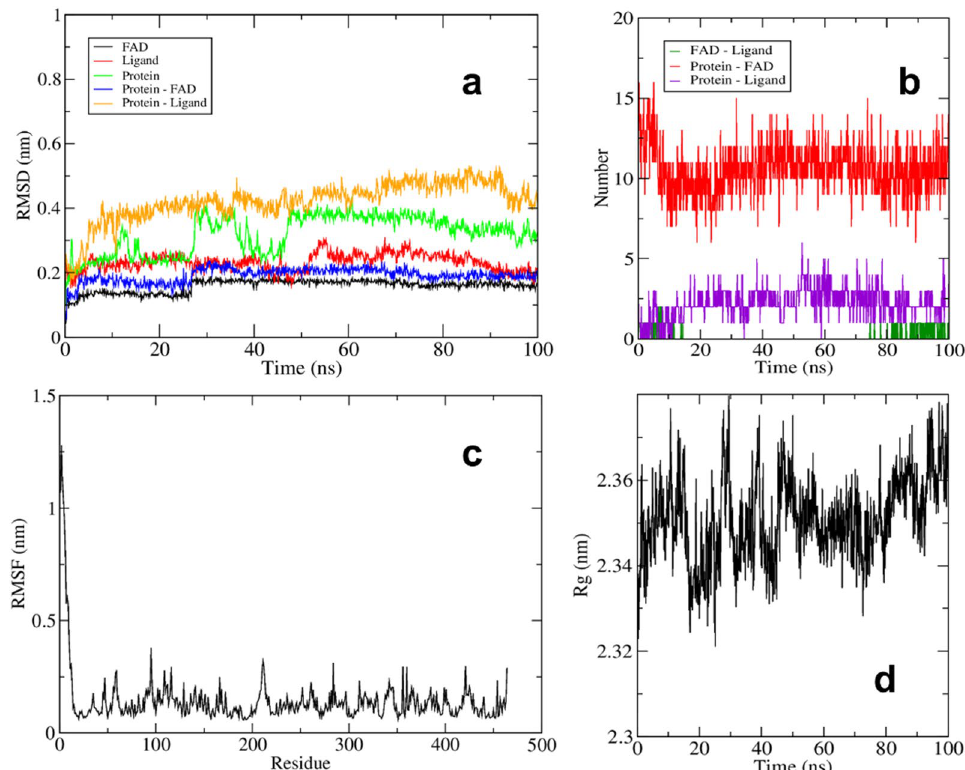
Fig. 3 Molecular dynamics results of the MAO‑A receptor ligand‑356 complex. a RMSD results of each component of the complex; b Hydrogen bonds formed between the components of the system; c RMSF of the MAO‑A; d Radius of gyration